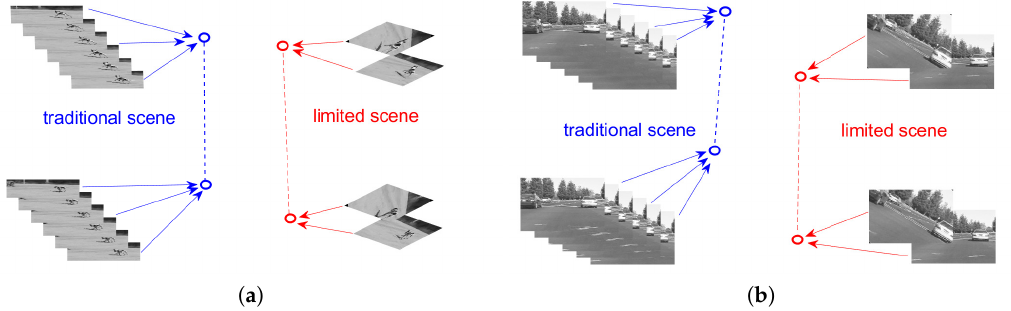
Figure 2. Illustration of a traditional and limited scenes: ( a ) Dog case; ( b ) Panda case. In both cases, a number of obtained frames can be